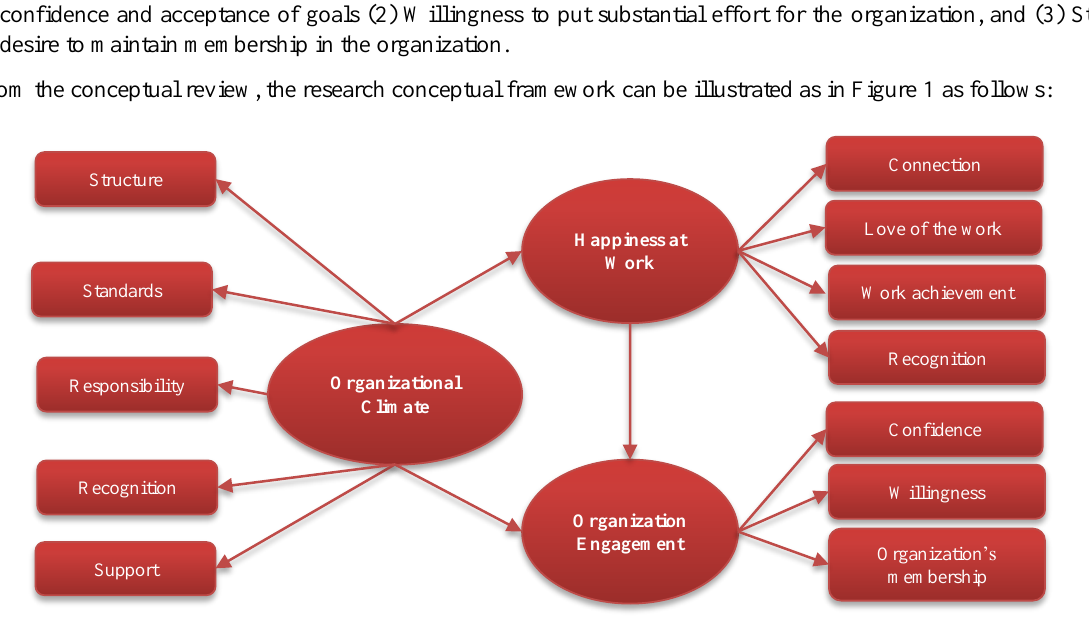
Figure 1. Research Conceptual